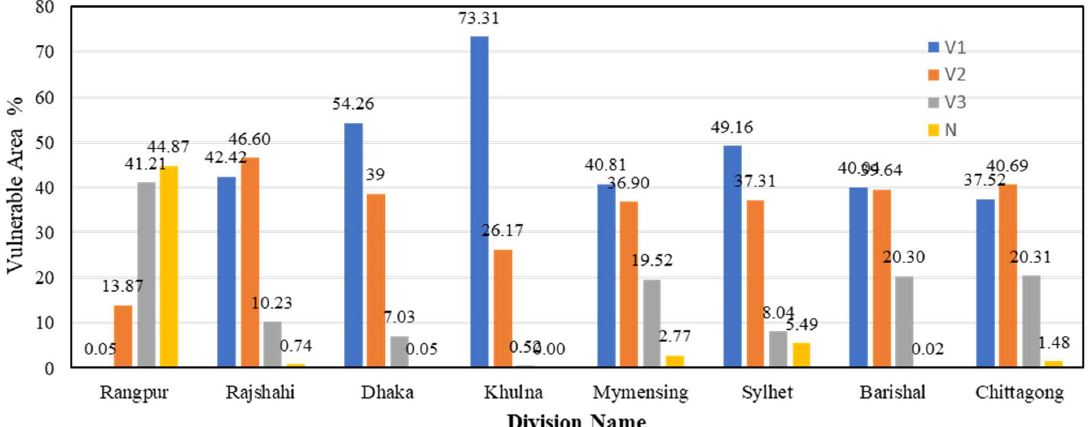
Figure 13. Vulnerable areas for agricultural land use by division according to the vulnerability classes in Bangladesh (V 1 : highly vulnerable area, V 2 : moderately vulnerable area, V 3 : marginally vulnerable area, and N: nonvulnerable area).